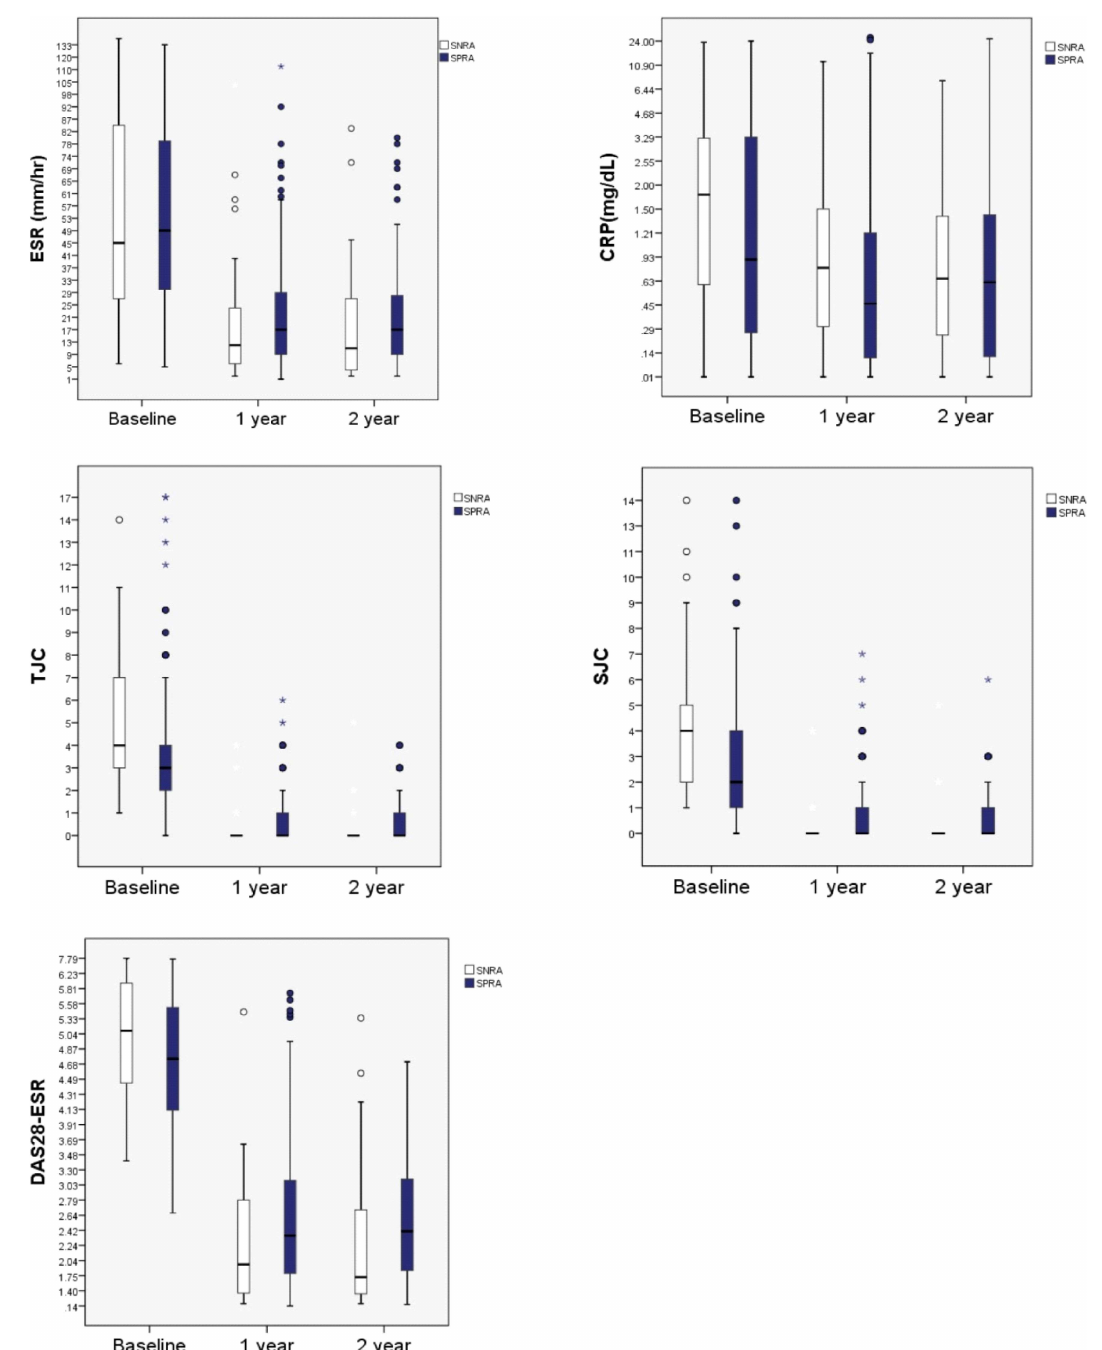
Fig 2. Disease activity measures (ESR, CRP, 28TJC, 28SJC and DAS28-ESR) all improved in both groups over the 2 years of treatment with DMARDs. Box plots for each disease activity measures at baseline, 1 year and 2 years after are displayed for each group (SNRA and SPRA). All the measures improved from baseline on both groups after treatment with DMARDs. DMARD: disease modifying antirheumatic drug, ESR: erythrocyte sedimentation rate, CRP: C-reactive protein, TJC: tender joint count, SJC: swollen joint count, DAS28-ESR: disease activity score 28